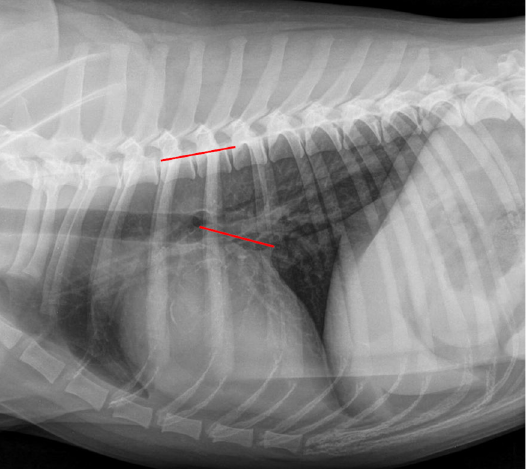
Figure 4. Measurement example of VLAS. The Vertebral Left Atrial Size (VLAS) measurement in the same right lateral thoracic radiograph is shown in Figure 1. A line was drawn from the ventral margin of the carina tracheae to the dorsal intersection between the cardiac silhouette and the caudal vena cava (red line on cardiac silhouette). This line was transposed onto the vertebral column (red line on vertebral) as described in Figure 1. The VLAS was 2.2 vertebral units.